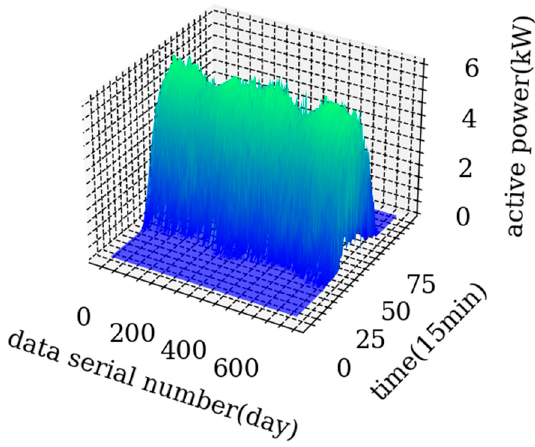
Figure 8. Historical data set of photovoltaic power.